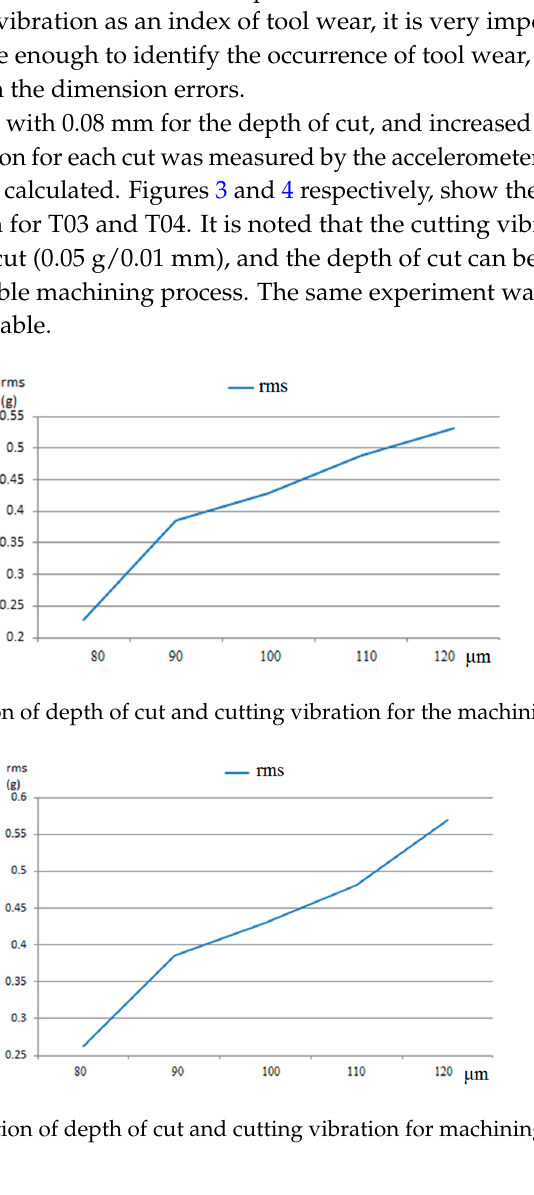
Figure 4. Correlation of depth of cut and cutting vibration for machining process T04.